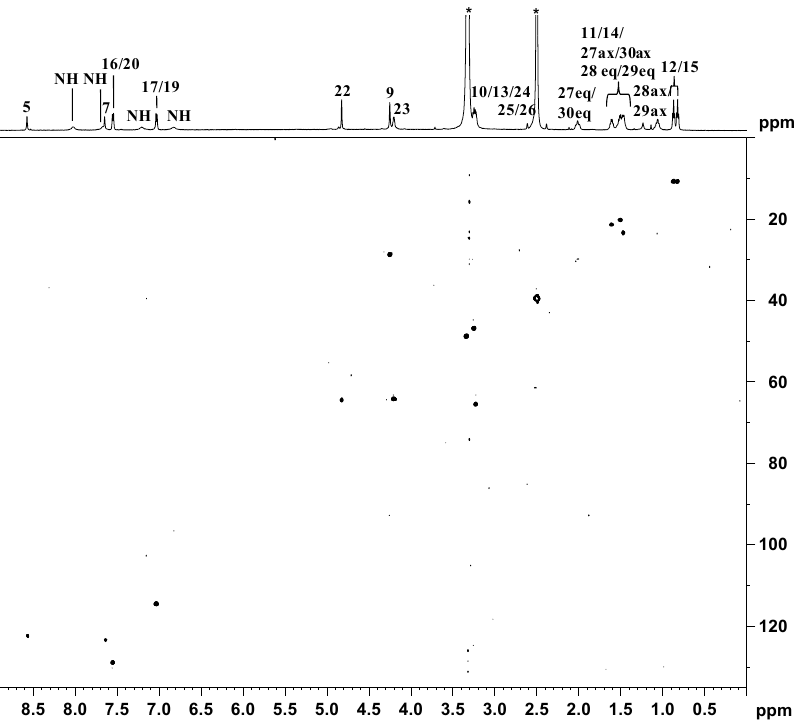
Figure 7. 1 H ( top ) and [ 1 H- 13 C] HSQC 2D ( bottom ) NMR (600 MHz, 1 H) spectra of 3 in DMSO- d 6 . The asterisks indicate residual solvent peaks.